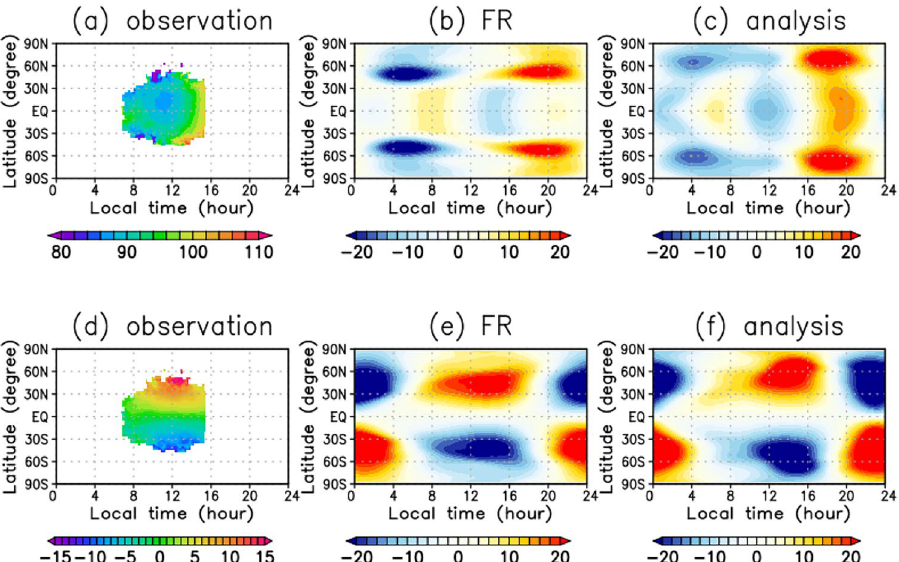
Figure 1. Local time and latitudinal distributions of ( a–c ) zonal winds (m s −1 ) and ( d–f ) meridional winds (m s −1 ) associated with thermal tides at the cloud-top (~ 70 km) level: ( a , d ) observation, ( b , e ) FR and ( c , f ) analysis. These distributions are averaged for the two Earth months from 1 October to 30 November 2018 in a reference frame moving with the Sun to extract the structures associated with thermal tides. Deviations from the zonal means of zonal and meridional winds are shown in ( b , c ) and ( e , f ),